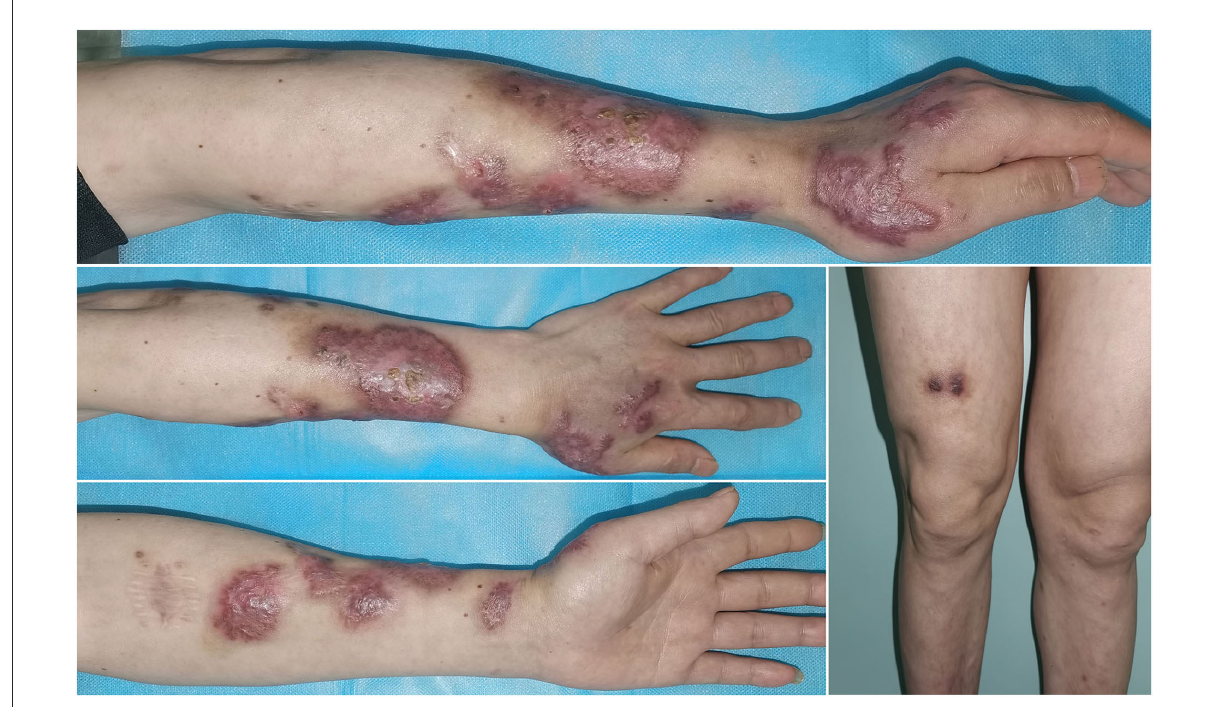
FIGURE4 After 6-month therapy of potassium iodide, the patient achieved complete remission with only scarring remaining.